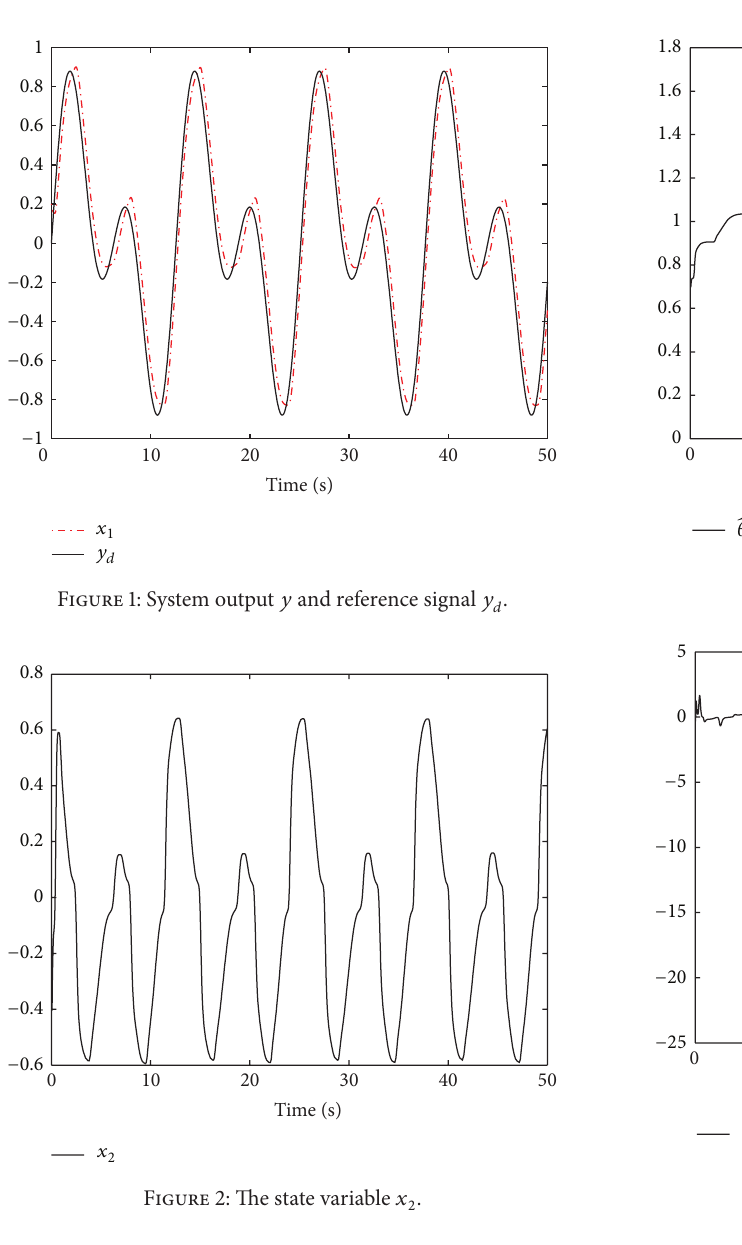
Figure 2: The state variable 𝑥 2 .